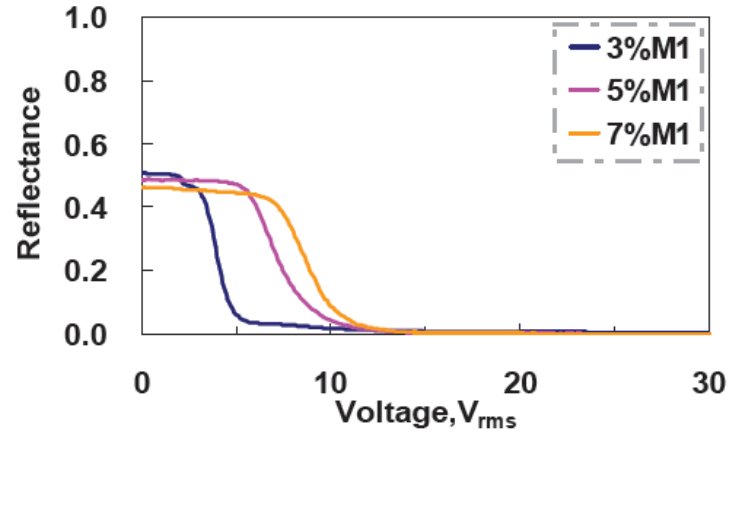
Figure 8. Voltage-dependent reflectance at three different monomer concentrations